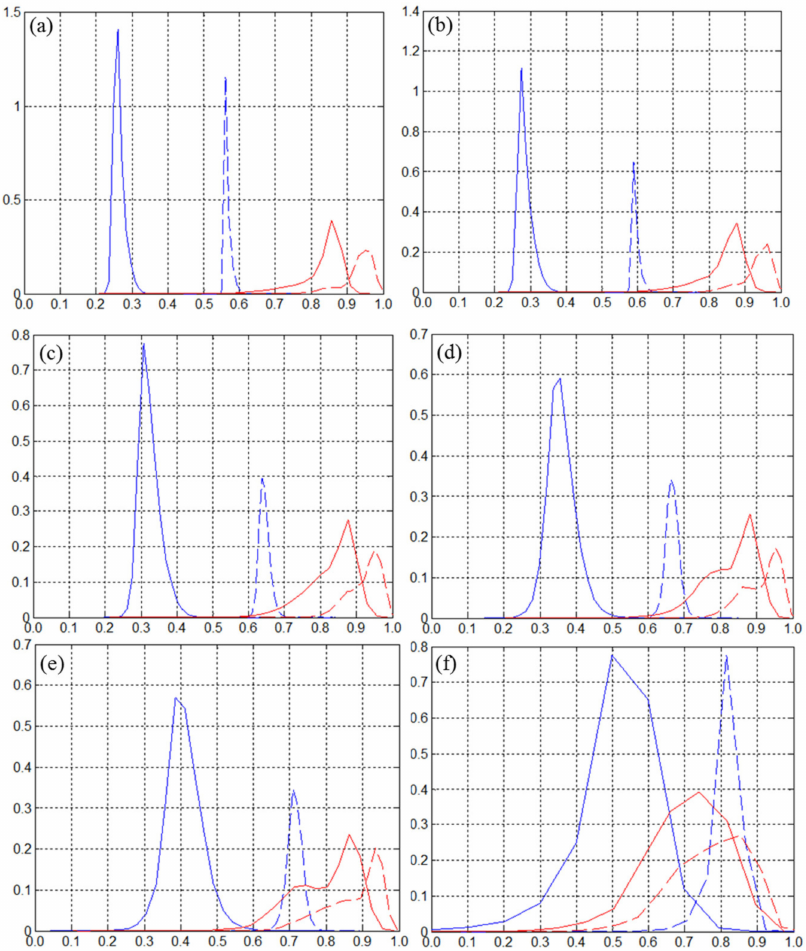
Figure 2. The probability density functions of the emission coefficients of the Arctic sea ice (red lines) and open water (blue lines), calculated from the AMSR2 measurements and ERA5 reanalysis for January–May, November and December of 2020: ( a ) 6.9 GHz, ( b ) 10.65 GHz, ( c ) 18.7 GHz, ( d ) 23.8 GHz, ( e ) 36.5 GHz, ( f ) 89 GHz. Solid lines—H polarization, dashed lines—V polarization.